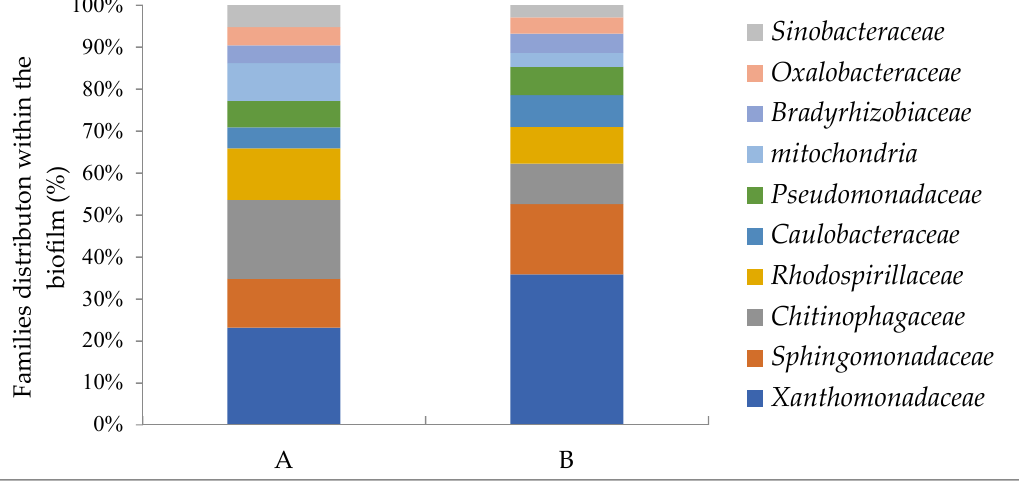
Figure 7. Bacterial distribution of the top 10 at the family level (81% and 67.5%, respectively of all identified families) which were identified in the biofilm grown on the plasma-treated ( A ) and untreated wood waste ( B ). Table 1. Bacterial relative distribution at the family level of the top 10, relative to all identified families in the original diesel contaminated soil, within the biofilm grown on the plasma-treated and untreated wood waste.